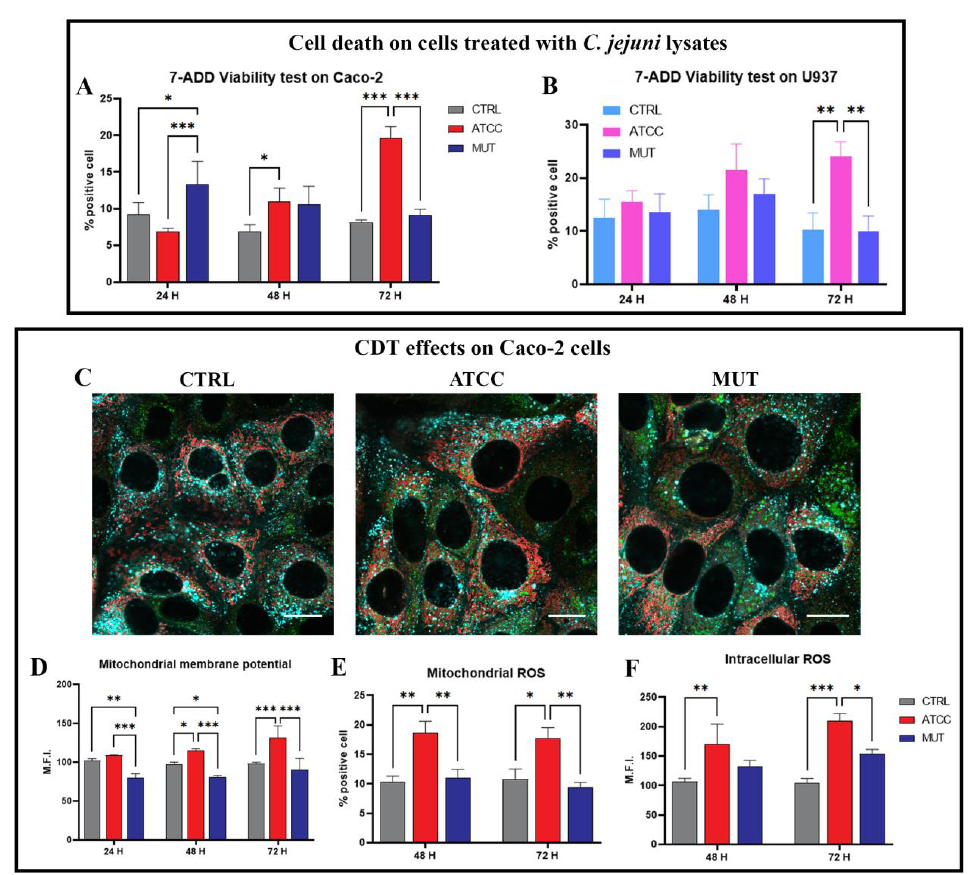
Figure 1. Evaluation of cell death, mitochondria dysfunction, and ROS production. ( A ) Statistical histograms of the percentage of 7 (cid:48) AAD positive cells from 24 h to 72 h on Caco-2 cells treated with C. jejuni lysates. ( B ) Statistical histograms of the percentage of 7 (cid:48) AAD positive cells from 24 h to 72 h on U937 cells treated with C. jejuni lysates. ( C ) Single confocal optical sections displaying an overlay of mitochondria (red), lysosome (cyan), and lipid droplets (green) at 48 h. Bars: 20 µ m. ( D ) Statistical histograms of the TMRE MFI value from 24 h to 72 h lysate administration on Caco-2 cells. ( E ) Statistical histograms of the MitoSOX MFI value from 48 h to 72 h lysate administration on Caco-2 cells. ( F ) Statistical histograms of CM-H2DCFDA MFI value from 48 h to 72 h lysate administration on Caco-2 cells. Each value is expressed as a mean ± SD (results from n ≥ three independent experiments). Two-way ANOVA with Bonferroni’s multiple comparison test revealed significant difference * = p < 0.05, ** = p < 0.01, *** = p <